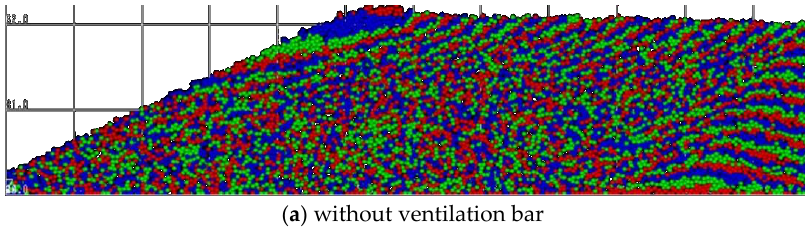
Figure 3. Schematic diagram of charging apparatus for discrete element method (DEM).